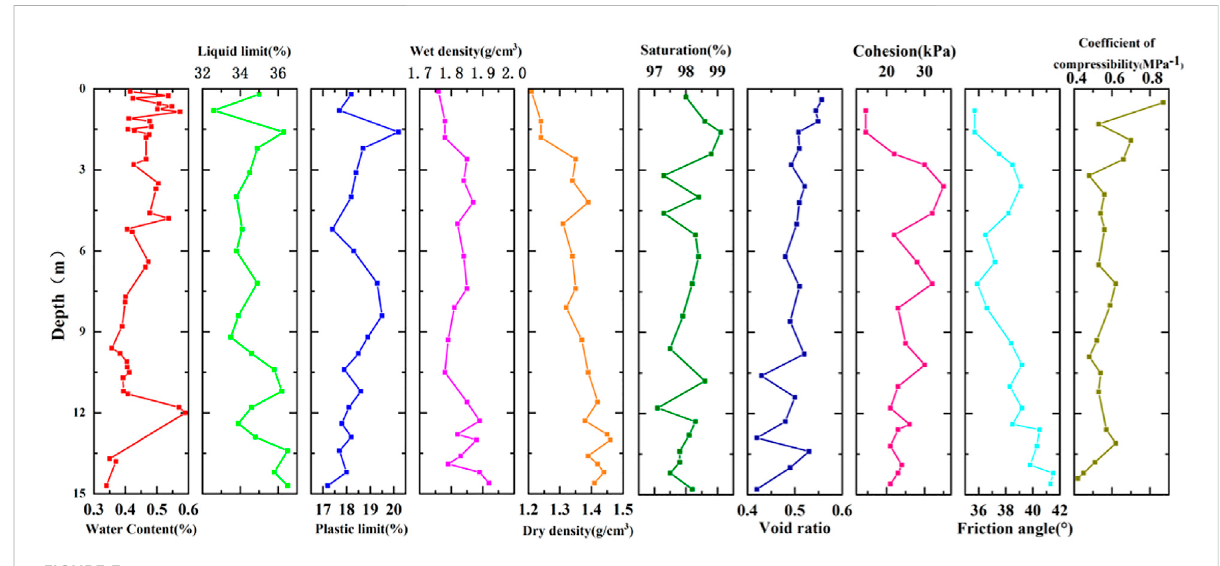
FIGURE 3 Physical and mechanical properties of seabed soils at a depth of 15